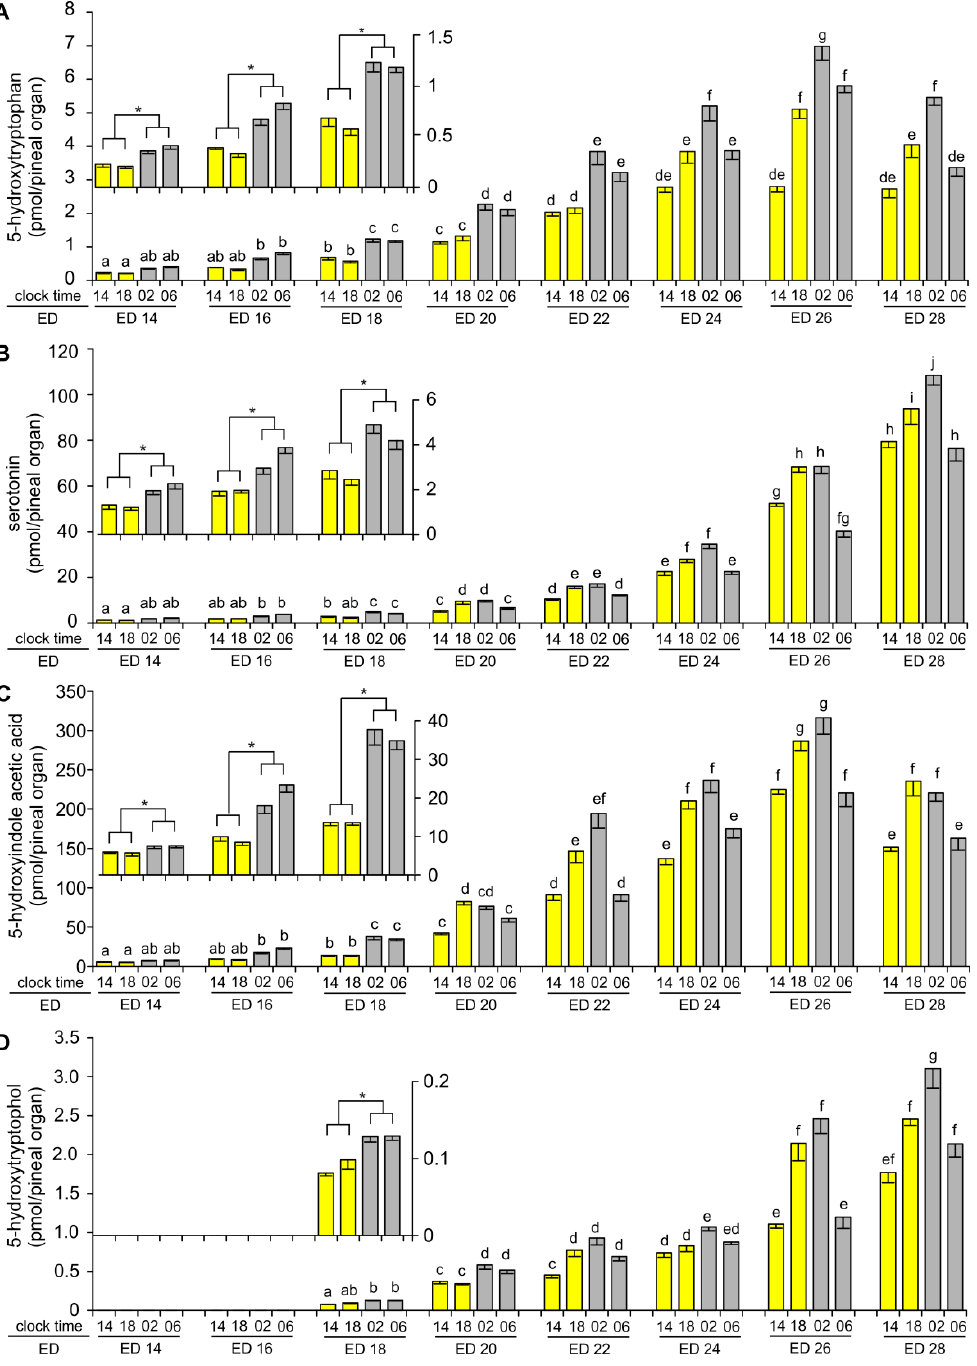
Figure 2. Content (means and SEM, n = 5) of 5-hydroxytryptophan ( A ), serotonin ( B ), 5-hydroxyindole acetic acid ( C ) and 5-hydroxytryptophol ( D ) in the pineal organs of geese embryos. Values labeled with different letters are significantly different in Duncan’s test performed as a post hoc procedure after two-way ANOVA. Inserts: Enlarged parts of charts showing data from ED 14, ED 16 and ED 18 embryos. Significant differences between sampling time points as showed by one-way ANOVA and Duncan’s test were signed with asterisk (*).